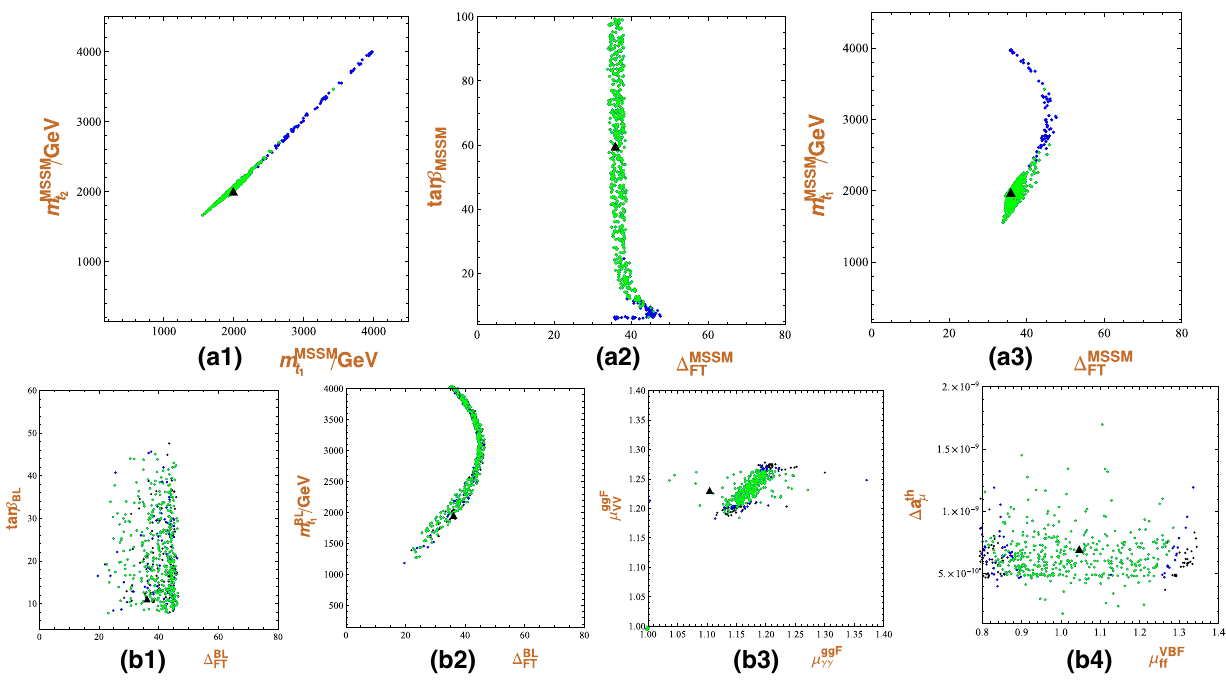
Fig. 2 The fitting results for MSSM and BLMSSM with the χ 2 analyses Higgs decays from PDG [3], which are μ exp γγ = 1 . 11